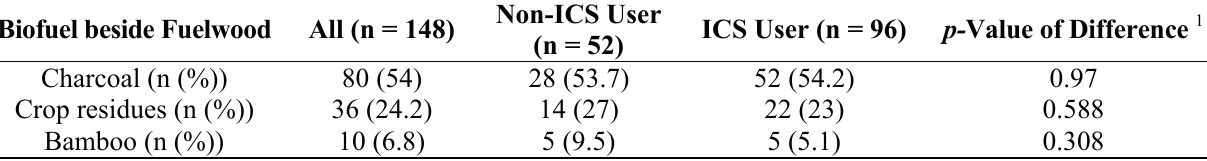
Table 2. Biomass fuel use beside fuelwood stratified by stove type.